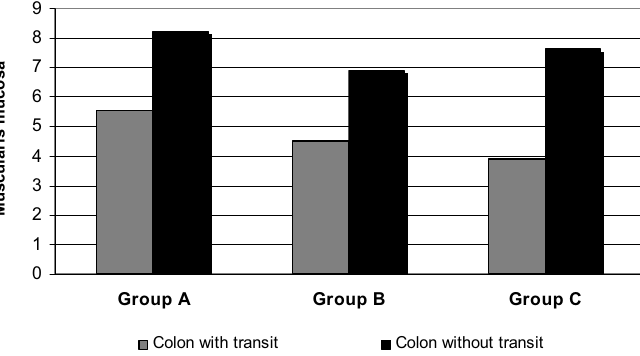
FIGURE 2 - Measurements obtained from computerized morphometry on the thickness of the colon muscularis mucosa, in the segments with and without intestinal transit in the experimental groups. Data is present as mean of micrometers. Student t test: p< 0.0001 for all groups.